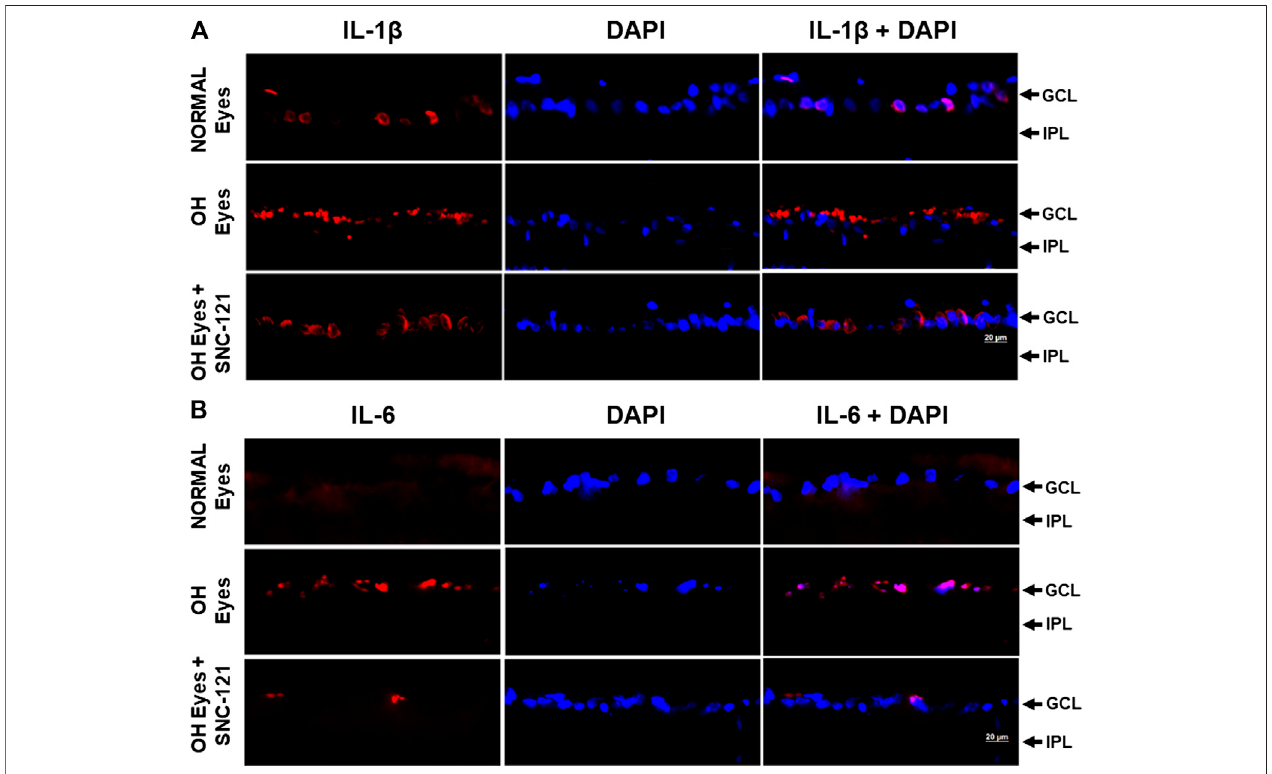
FIGURE 2 | Effects of δ -opioid receptor agonist (SNC-121) treatment on interleukin-1 β (IL-1 β ) (A) and interleukin-6 (IL-6) (B) production in ocular hypertensive animal.Animalswereeuthanizedandeyeswereenucleatedatday7,posthypertonicsalineinjections.Retinacryosectionswereimmunostainedusingaselectiveanti-IL- 1 β or anti-IL-6 antibody. The nuclei were counterstained with DAPI. Red color indicates staining for IL-1 β and IL-6 and blue for the nuclei. There was no positive immunostaining when primary antibodies were omitted (not shown). Data shown here is a representation of at least four independent experiments. We have used four animals in each treatment group. OH Eyes; ocular hypertensive eyes; OH Eyes + SNC-121, ocular hypertensive eyes with SNC-121 treatment, bar size 20 µm.